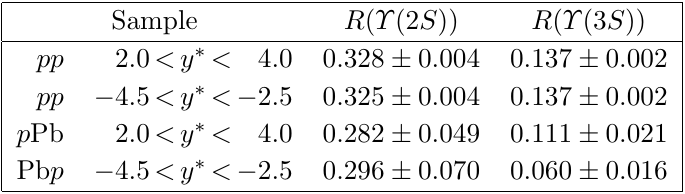
Table 3 . Ratio R ( nS ) in pp , p Pb, and Pb p samples. The uncertainties are combinations of statistical and systematical